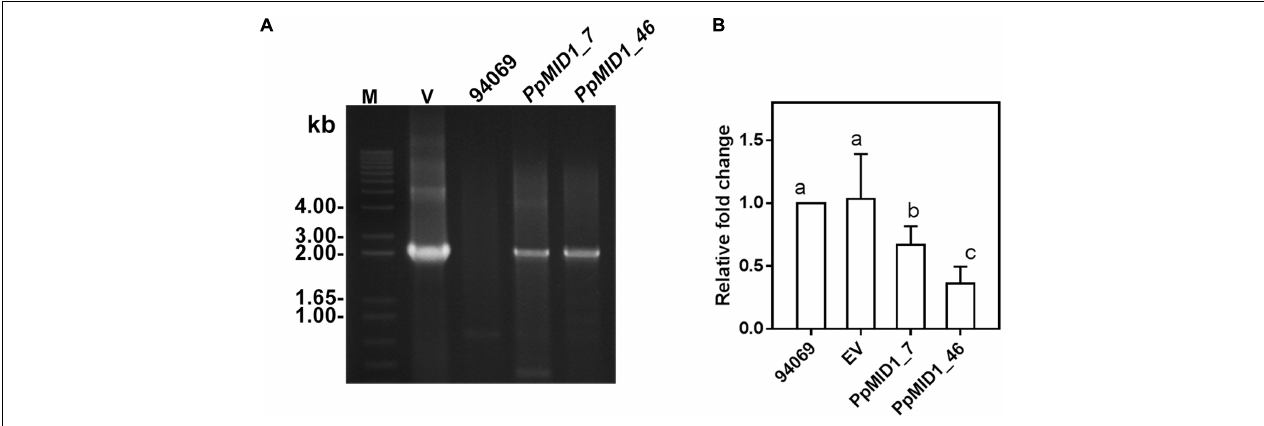
FIGURE 3 | Analyses based on PCR and qRT-PCR show both PpMID1_7 and PpMID1_46 as Phytophthora parasitica transformants. (A) PCR analysis. Genomic DNAs extracted from the PpMID1- silenced transformants ( PpMID1_7 and PpMID1_46 ) and wild-type P. parasitica (94069) were amplified with the primers nptF1 and transR2. V, plasmid DNA as the PCR template; M, size marker (in kb). (B) The expression of PpMID1 is downregulated in the mycelium of PpMID1- silenced transformants. qRT-PCR analysis of total RNA from the mycelia of PpMID1_7 and PpMID1_46 , the empty vector transformant (EV), and the wild type (94069). Raw data were normalized by transcripts of WS21 as an internal control and shown as fold change relative to that of the wild-type strain. Data are mean ± SD from 3 independent experiments. Different letters indicate significant difference by Fisher’s least significant difference test ( P < 0.05).